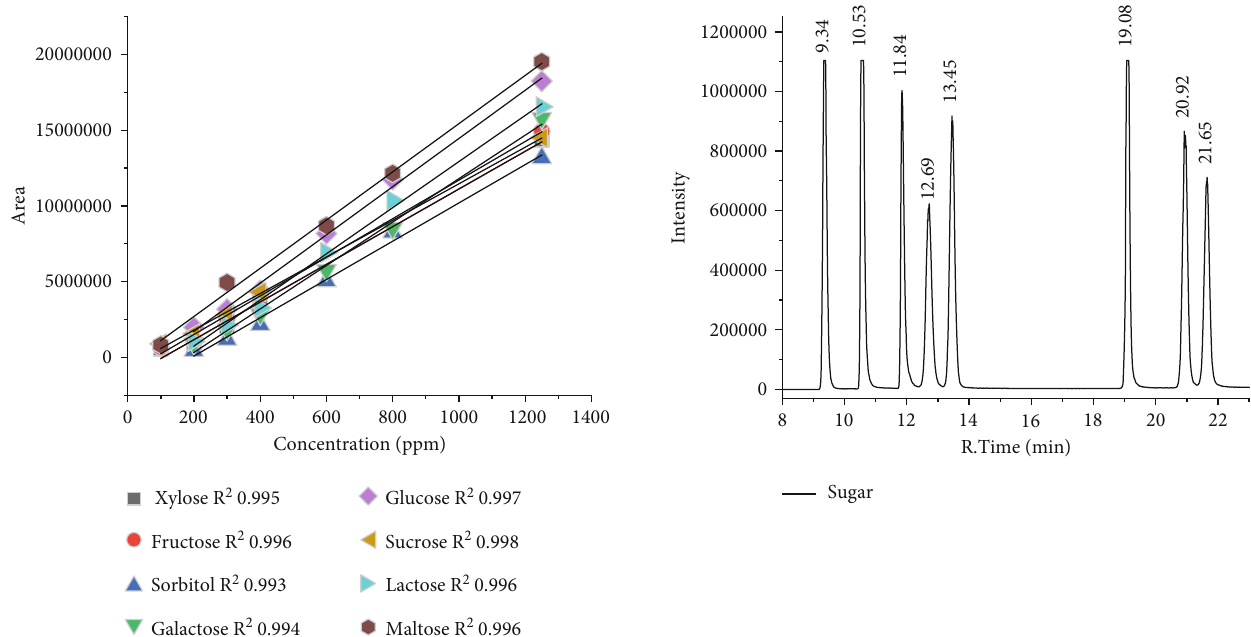
Figure 5: Calibration curve and chromatogram of sugar